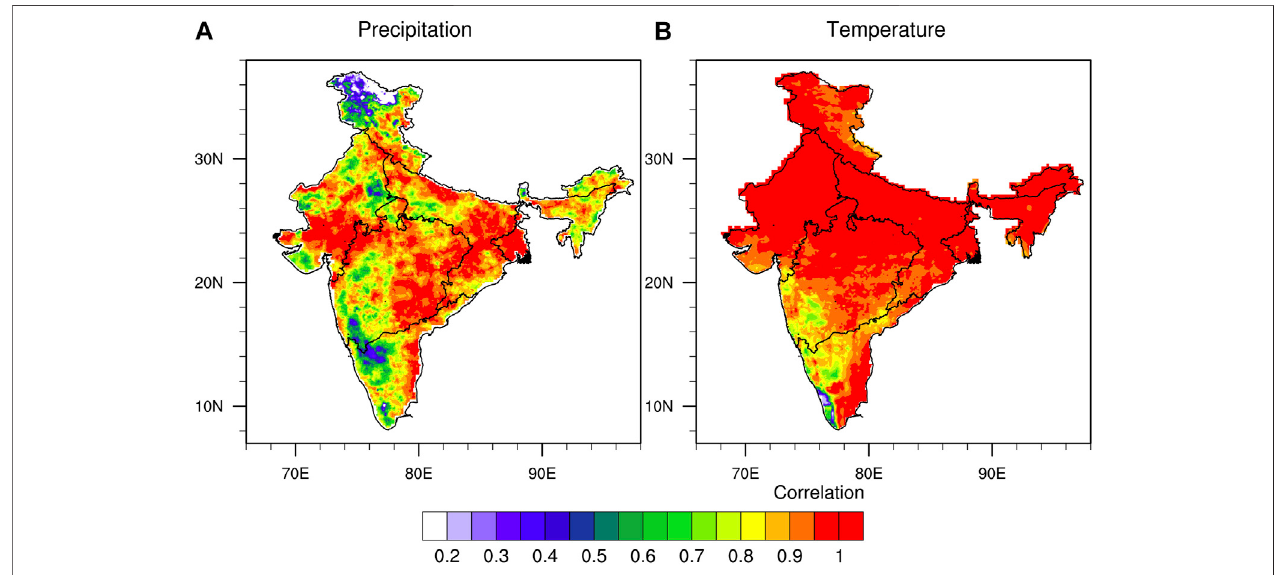
FIGURE 3 | Correlation between observed (GPM for precipitation and IMD for temperature) and simulated (from WRF model) daily datasets of (A) precipitation (B) temperature in 2015.